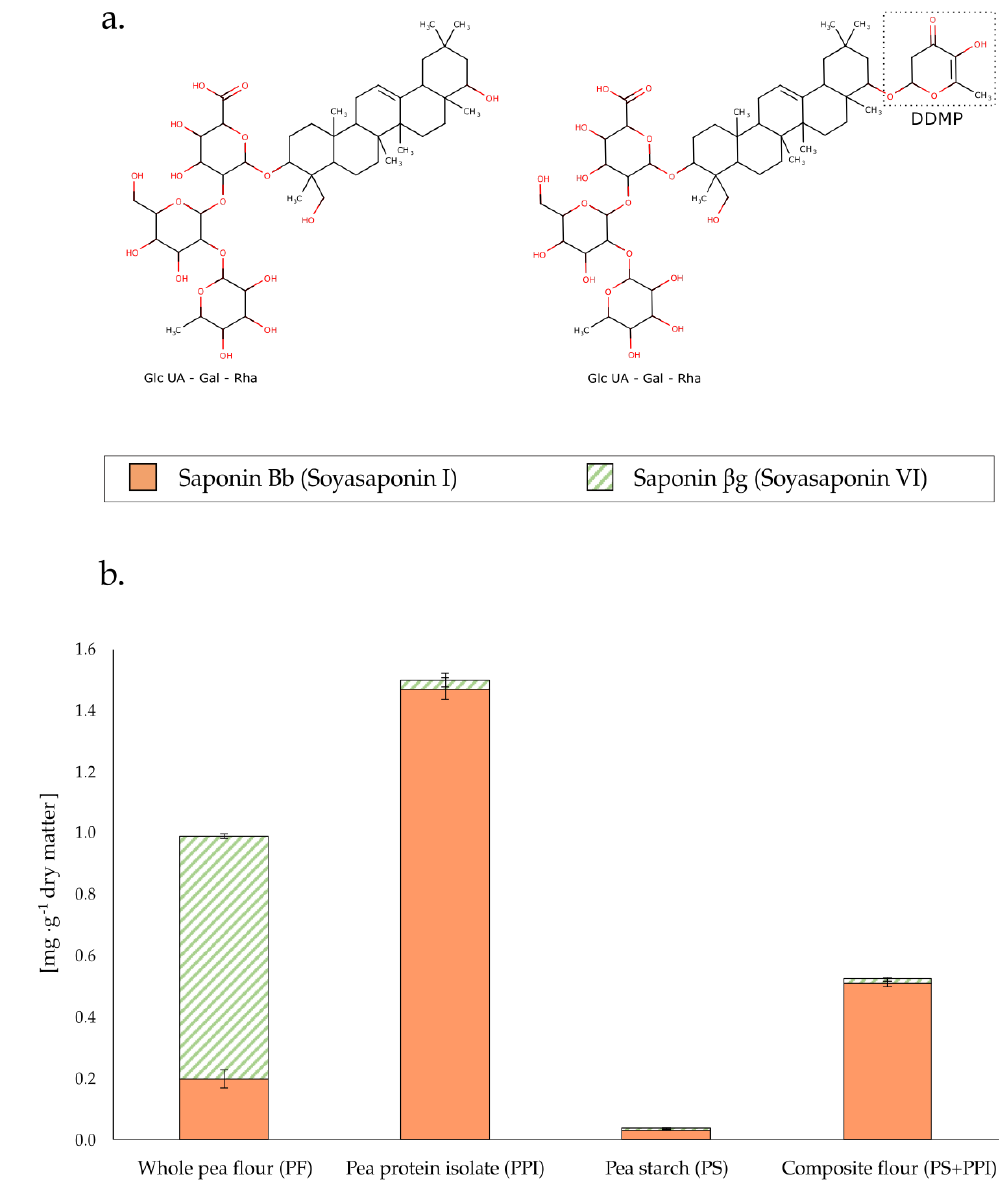
Figure 1. ( a ). Chemical structures of saponin Bb (on the left) and saponin β g (on the right). β g presents 2,3-dihydro-2,5-dihydroxy-6-methyl-4H-pyran-4-one (DDMP) attached to the aglycone C22, while in Bb this pyranone is substituted by a hydroxyl group. ( b ). Quantities of the two saponins measured in the flours (PF and PS + PPI) and the individual fractions (PPI and PS). Saponin concentrations in PS + PPI were calculated considering PS + PPI as a 2:1 mixture ( w / w ) of PS and PPI. Therefore, the resulting saponin concentrations in PS + PPI were determined using the following equation: C PS+PPI = 2 × C PS + 1 × C PPI , where C represents the concentration of either one of the saponins quantified. Saponin β g is represented in striped green and saponin Bb in orange. In terms of the total quantified saponin concentration, PPI presented the highest concentration (1.497 mg · g − 1 dry matter), followed by PF (0.988 mg · g − 1 dry matter),